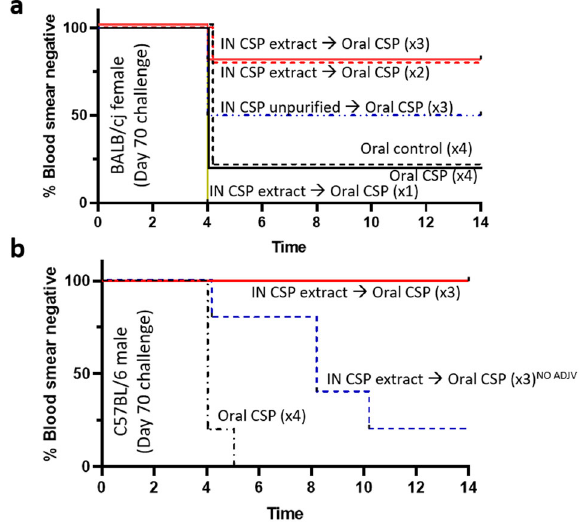
Fig. 4 Protection after spirulina PfCSP vaccination. a Female BALB/cJ mice were intranasally primed and then orally boosted as in Fig. 2 and then challenged subcutaneously with PfCSP Py spz 14 days after the fi nal vaccination n = 5 mice/group; representative of two replicate experiments. Survival curve shows endpoint of protection based on blood smear positivity. p = 0.01 (IN CSP extract priming and 2 – 3 doses of oral CSP vs. IN CSP extract priming and one dose of oral CSP), p = 0.07 (IN CSP extract priming and 2 – 3 doses oral CSP vs. oral control or oral CSP only), p = 0.37 (IN CSP unpuri fi ed priming and 3 doses of oral CSP vs. oral control or oral CSP only) (log-rank Mantel-Cox test). b Survival curve as in panel a for male C57Bl/6J mice. Vaccination regimens are shown in the text adjacent to each line. All vaccines shown contained Montanide except where indicated NO ADJV. p = 0.002 (adjuvanted vaccine vs. oral CSP only), p = 0.01 (no adjuvant vaccine vs. oral CSP only), p = 0.01 vaccines with vs. without adjuvant (log-rank Mantel- Cox